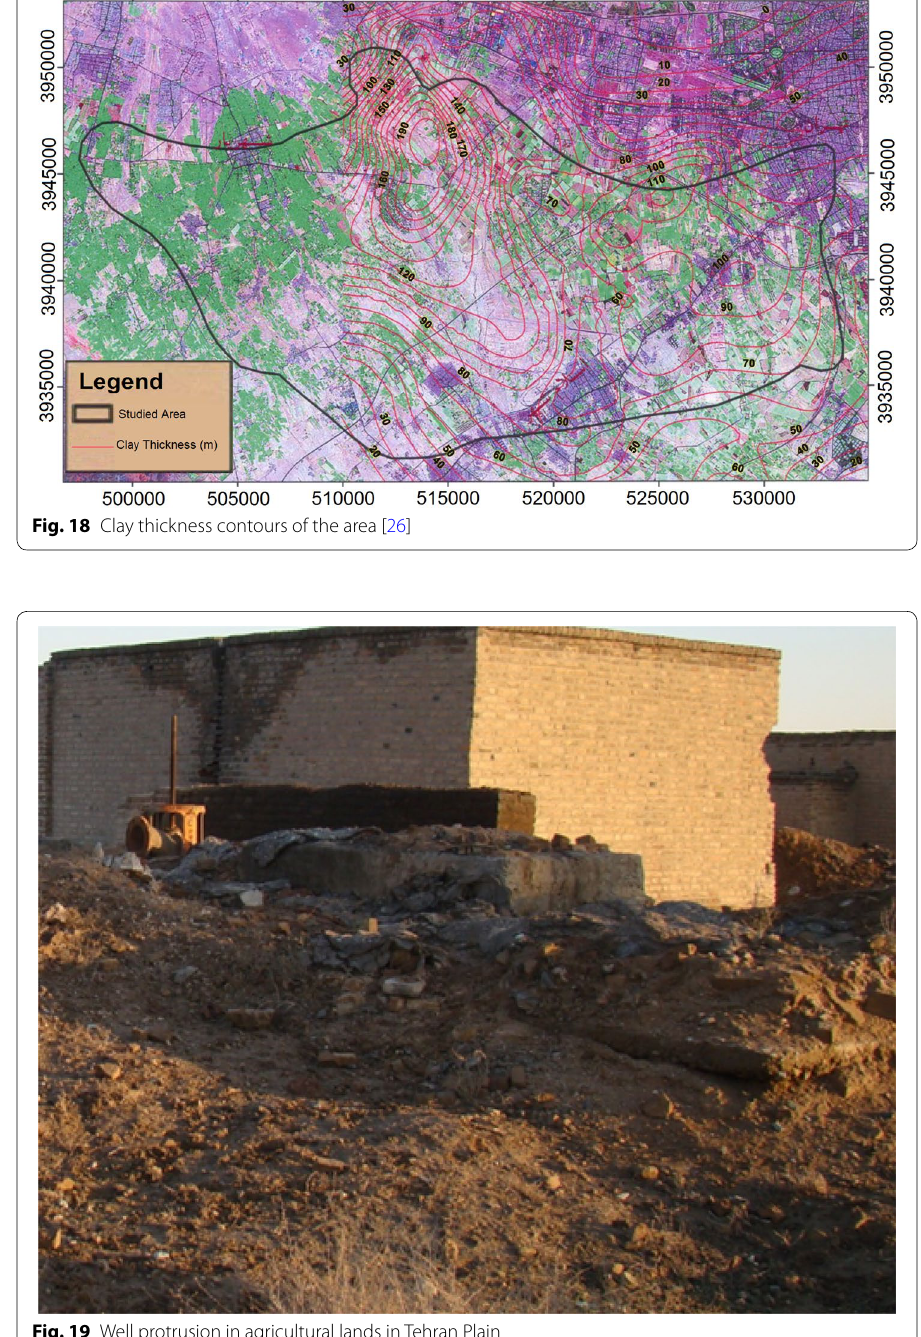
Fig. 19 Well protrusion in agricultural lands in Tehran